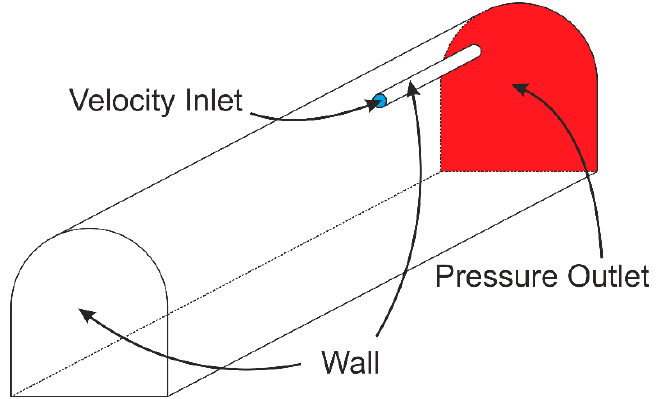
Figure 6. Boundary conditions of the simulations.